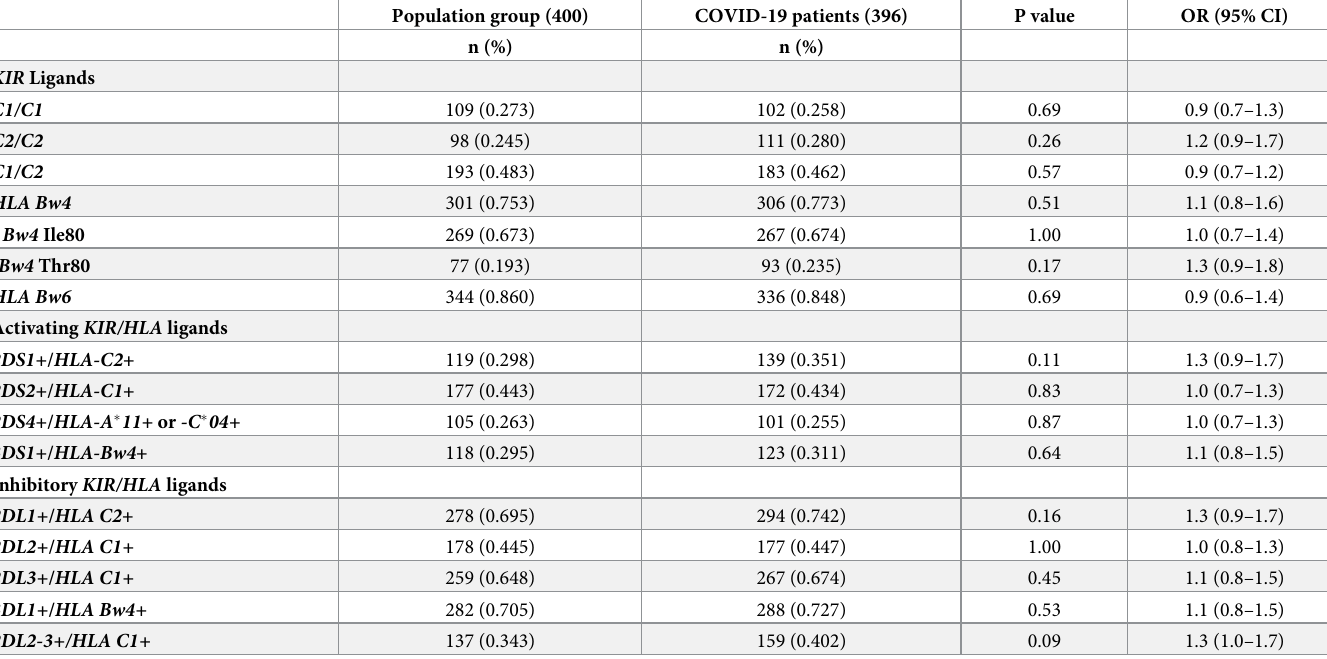
Table 3. Comparisons of KIR genes and their cognate HLA ligands between COVID-19 patients and the population group.